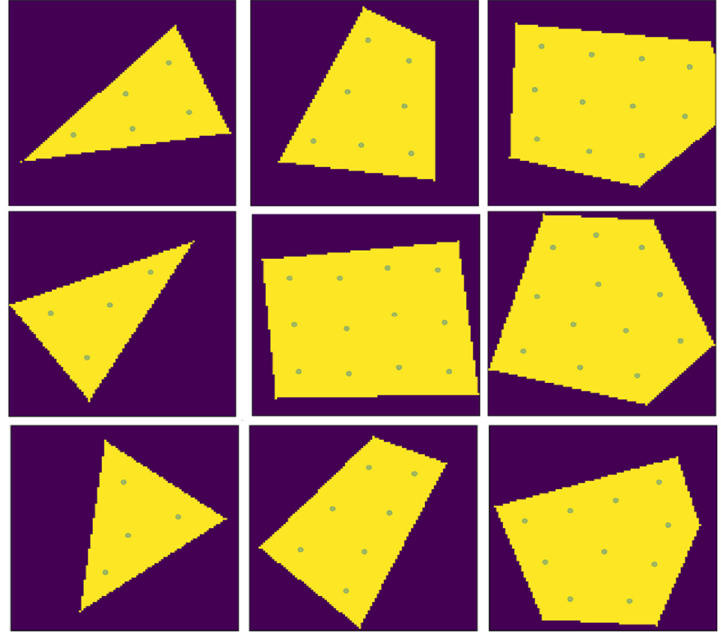
Figure 6. Well placement on many random reservoir shapes through the constrained-Kmeans method. Yellow areas are active grids in the formation, purple areas are inactive, and blue scatters are positions of wells.